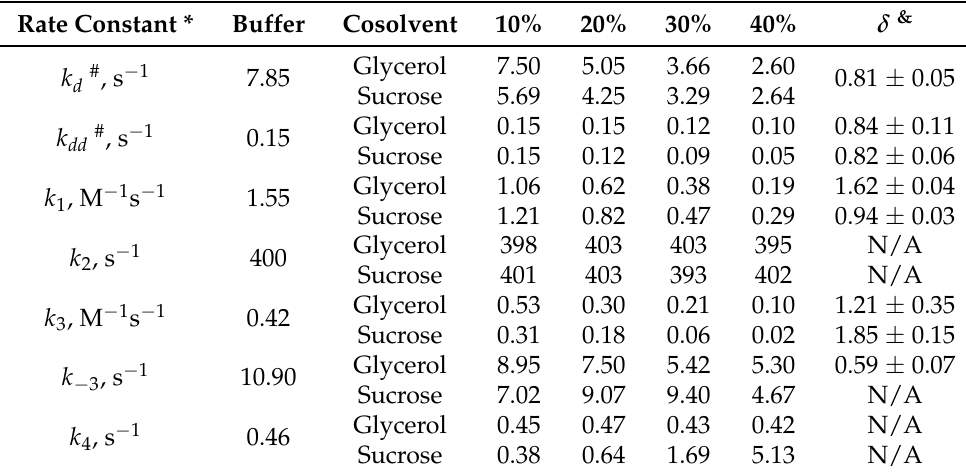
Figure 4. The kinetic curves of the bioluminescent reaction with 10, 20, 30, 40 and 50 µ M of decanal in media with 30% of sucrose (the gray thick lines), their simulation by mathematical model with the constants indicated in Table 1 (the black solid lines) ( A ), and corresponding relative deviations of the simulated curves from the experimental ones ( B ). Table 1. The calculated rate constants for the separate stages of the reaction, catalyzed by bacterial luciferase, in viscous